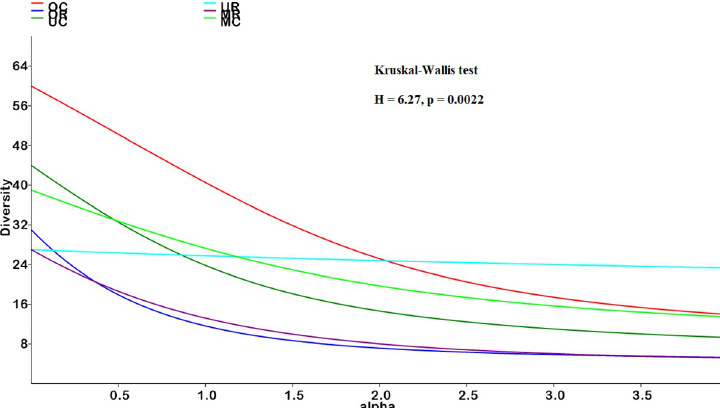
Fig 4. Diversity profiles of overstorey, midstorey and understorey floral species in the rehabilitated and control sites using Renyi’s index family. OC, MC, and UC are respectively overstorey, midstorey, and understorey species in the control sites while OR, MR, and UR are respectively overstorey, midstorey, and understorey species on the rehabilitated sites. Thick lines represent main diversity